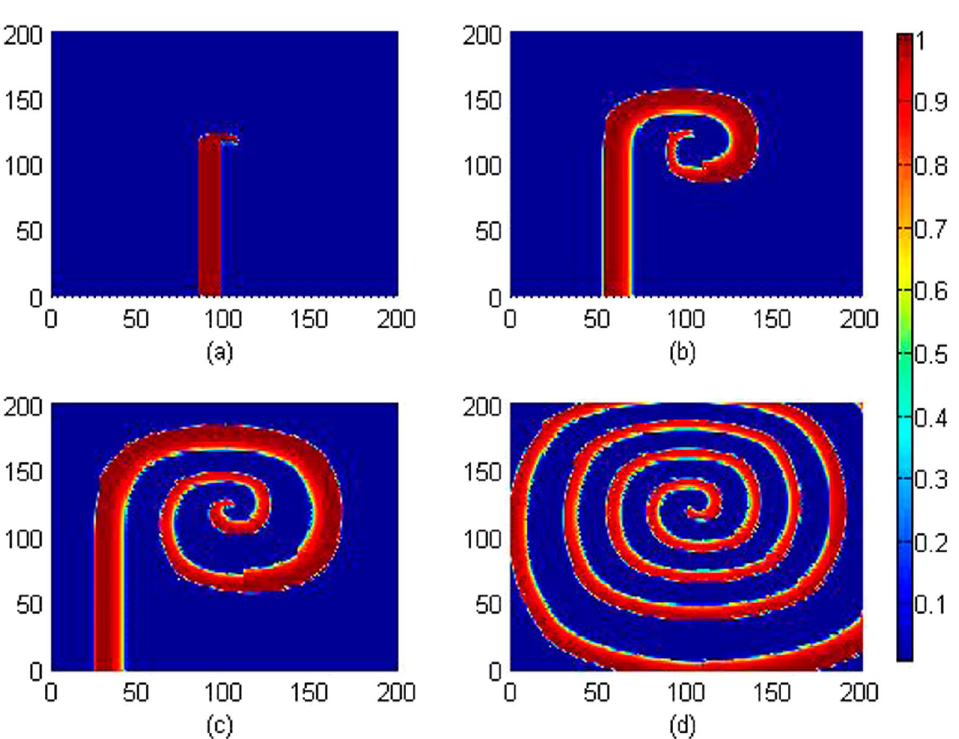
Figure 10. Developed spatial pattern is plotted for the cardiac tissue at t = 10, 60, 100, 200 time units under feedback gain k 1 = 0.2, at k 0 = 0.1, k 2 = 1.0, α = 1, β = 2. The snapshots are shown color